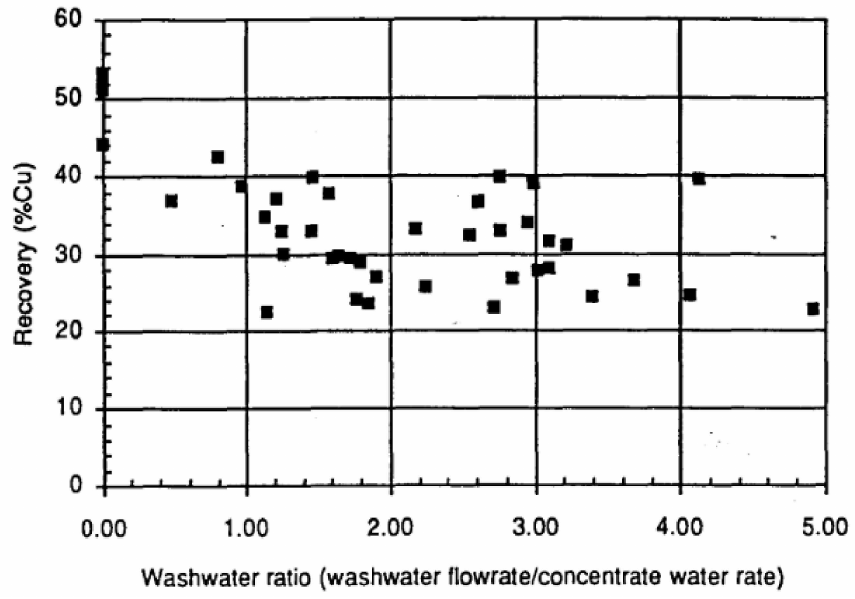
Figure 12. Effect of wash-water ratio on recovery in the flotation of copper retreatment [34].